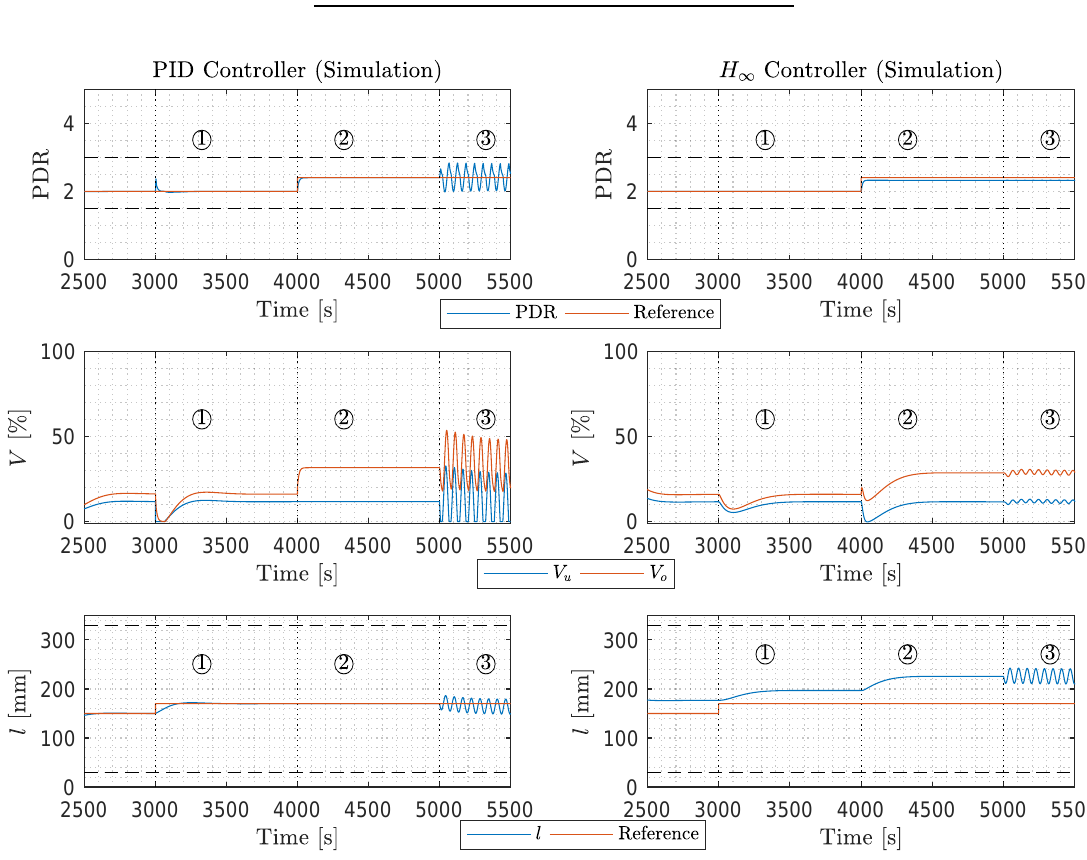
Figure 6. Performance analysis of the H ∞ control solution in comparison to the PID control solution in simulations. The scenario changes are indicated by dotted lines, while the minimum and maximum limits are represented with dashed horizontal